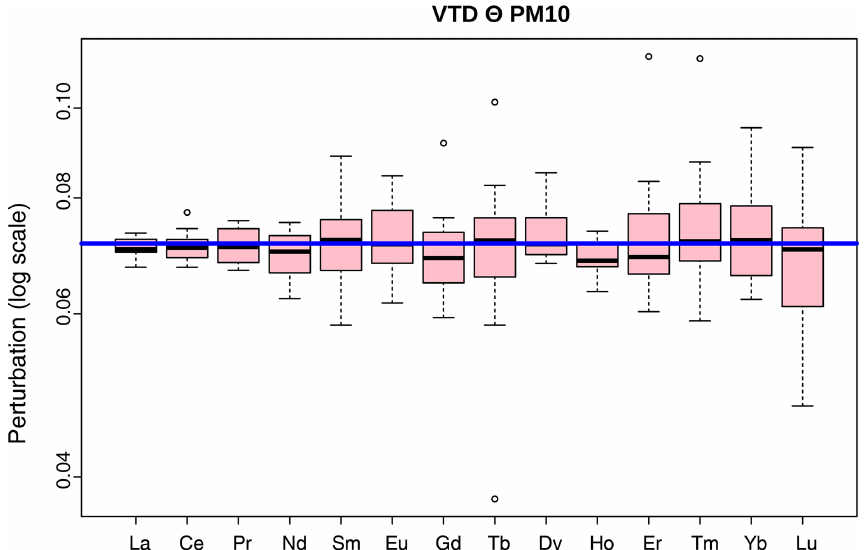
Figure 10. REE perturbation diagram as box plots for paired samples, measured by PM10 and the VTD. The horizontal blue line represents no